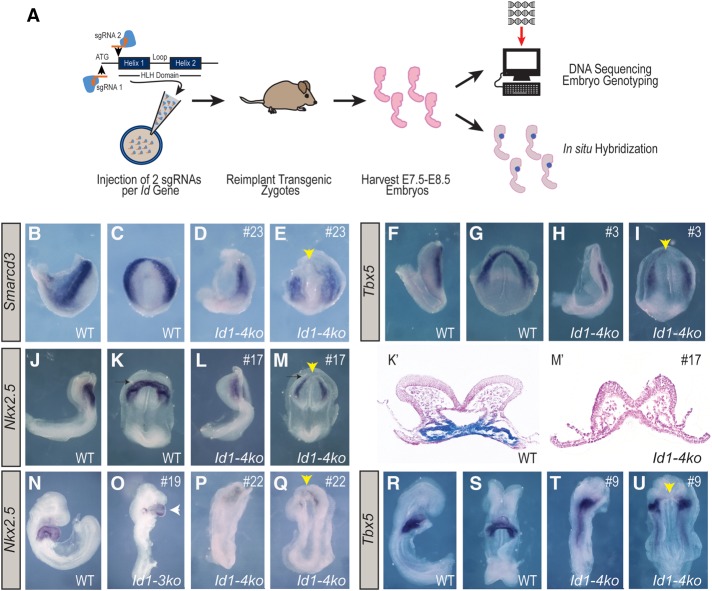
Id genes are essential for early heart formation. (A) Schematic illustrating the generation and analysis of Id1–4 mutant embryos using CRISPR/Cas9 technology. Two sgRNAs per gene (targeting the translational start site and the HLH domain) were injected into single-cell mouse zygotes alongside Cas9 mRNA. Zygotes were reimplanted and harvested at stages E7.5–E8.5. Resulting embryos were genotyped by DNA deep sequencing, and cardiac gene expression was assessed via whole-mount in situ hybridization. (B–U) In situ hybridization results from the most severe Id1–4 mutants—compared with wild type (individual mutants are marked by #)—plus one less-affected mutant (O); analysis of Smarcd3 at E7.75 (B–E), Tbx5 at E8.0 (F–I), Nkx2.5 at E8.25 (J–M; plus transverse sections through the heart tube-forming region [K′, M′]), Nkx2.5 at E8.5 (N–Q), and Tbx5 at E8.5 (R–U). (Yellow arrowheads) Missing heart tube (or missing heart tube-forming region at cardiac crescent stages) in Id1–4 mutants; (white arrowhead) malformed heart tube; (black arrows) the plane of transverse sectioning through the heart tube-forming region; (black dashed arrows) posterior–lateral cardiac regions. See the Supplemental Material for detailed sequencing results of mutant embryos.